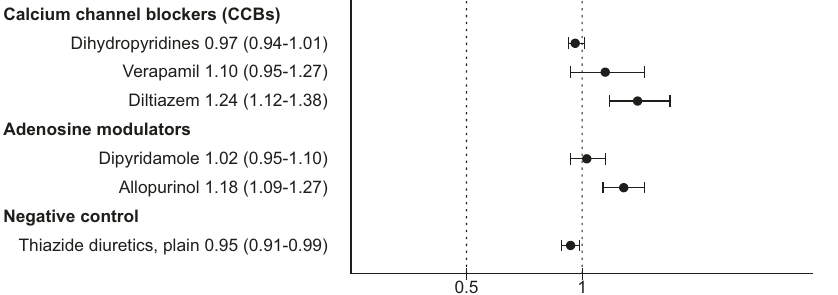
Fig. 2 Risk of nonpsychiatric hospitalization associated with add-on drug use compared with nonuse of add-on drug, within-individual model. Hazard ratios with 95% con fi dence